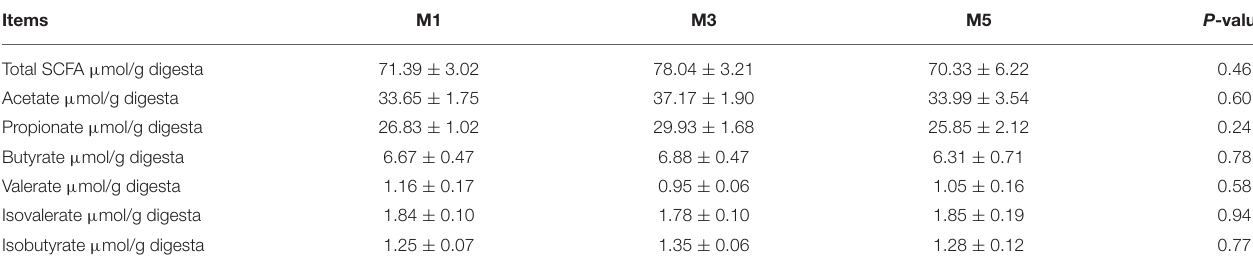
TABLE 3 | Concentrations of short-chain fatty acids (SCFAs) in the colonic digesta in pigs a . Items